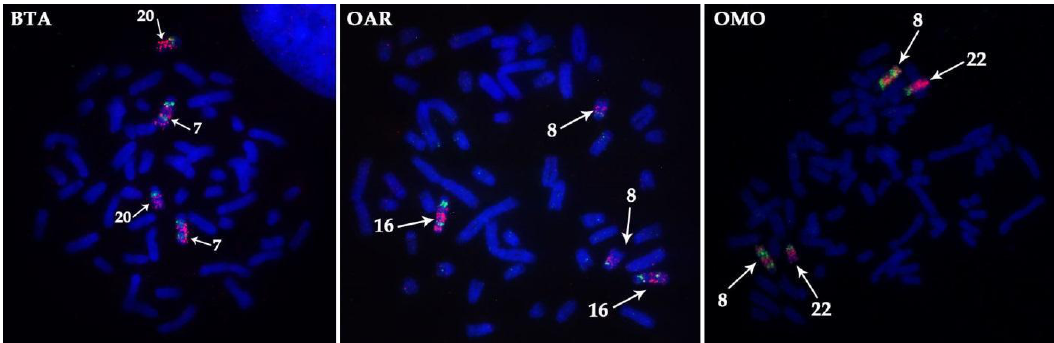
Figure 5. Localization of CDR 22 (green) and CDR 3 (pink) on BTA ( Bos taurus ), OAR ( Ovis aries ), and OMO ( Ovibos moschatus ) metaphase chromosomes by FISH showing additional previously unreported by painting fragment homologous to CDR22. White arrows indicate chromosomes with specific